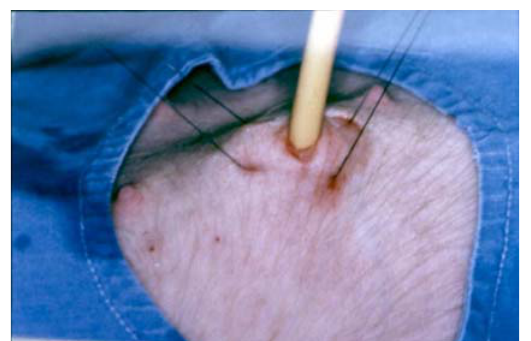
FIGURE 11 - Schematic view of Foley catheter pulled opposite to the abdominal wall.